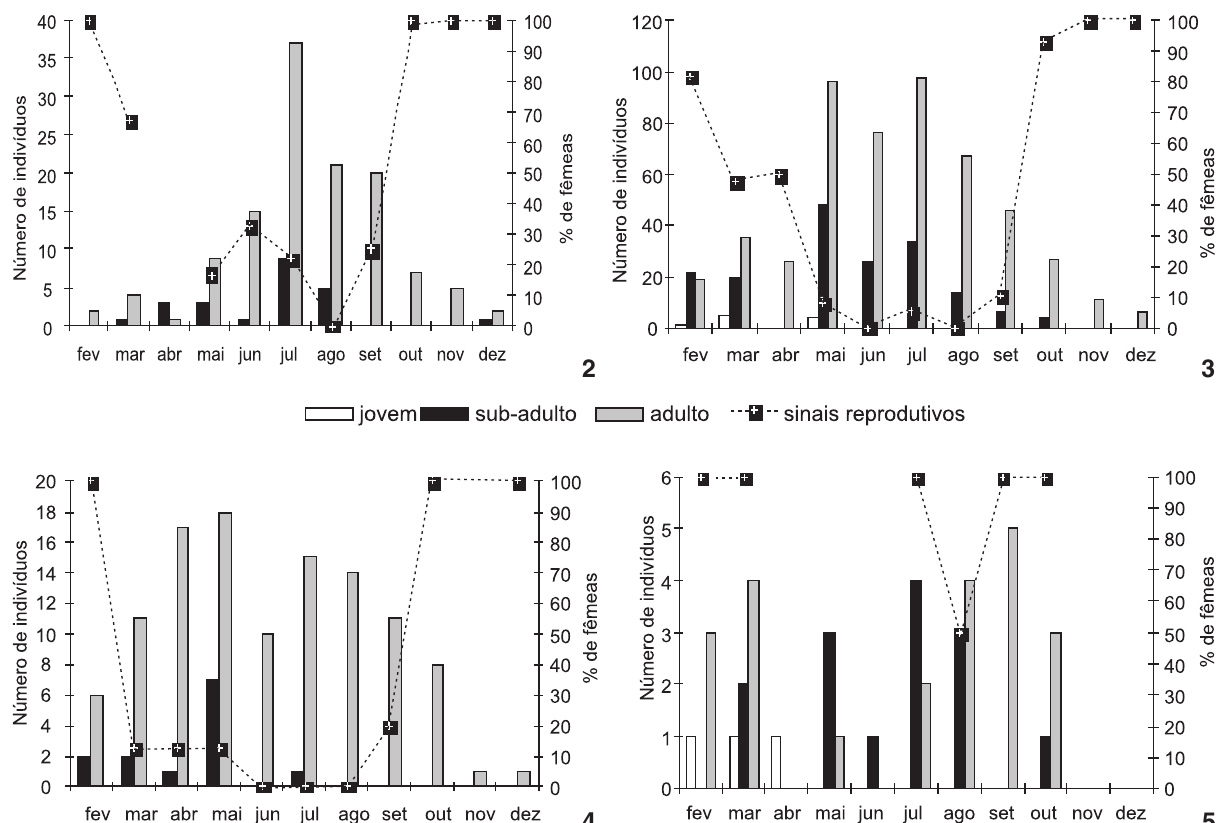
Figuras 2-5. Freqüência relativa mensal de sinais reprodutivos em fêmeas e número de indivíduos de cada classe etária ao longo do ano, a partir dos dados mensais dos anos de 2006 e 2007: (2) G. agilis ; (3) M. demerarae ; (4) M. domestica ; (5) P. opossum